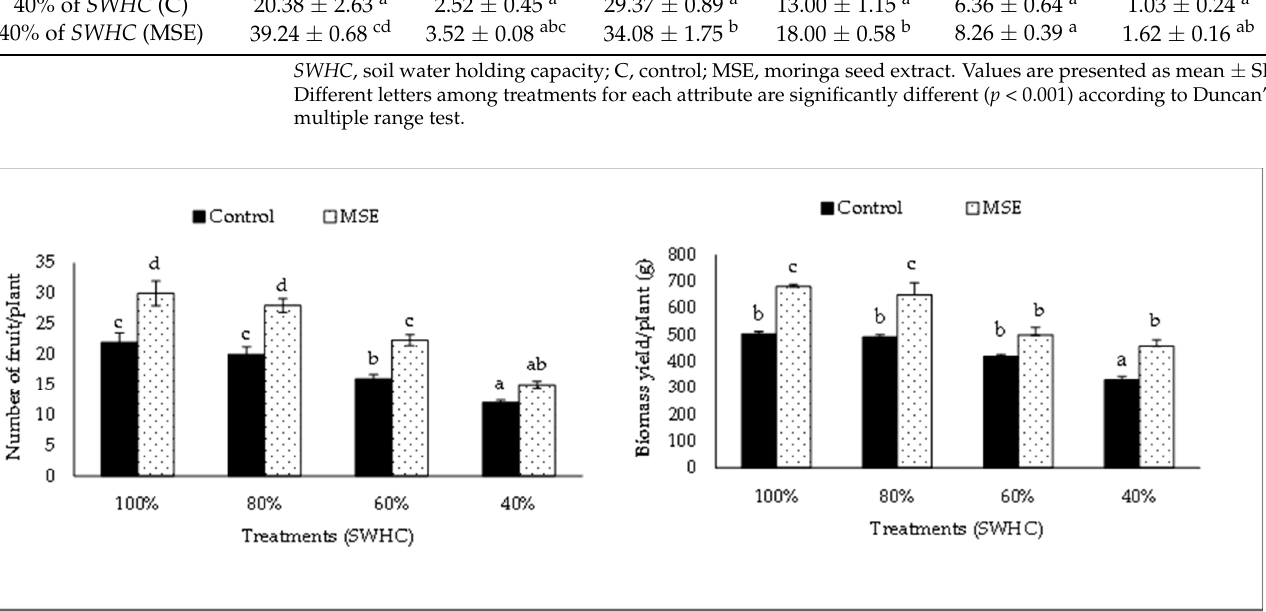
Figure 1. Number of fruit/plant and biomass yield/plant of cancer bush ( S. frutescens ) treated with moringa ( M. oleifera ) seed extract (MSE) under deficit irrigation conditions. SWHC = soil water holding capacity. Vertical bars represent standard error (SE) of the mean value ( n = 3). Means followed by different letters in each bar indicate a statistically significant difference ( p < 0.001).